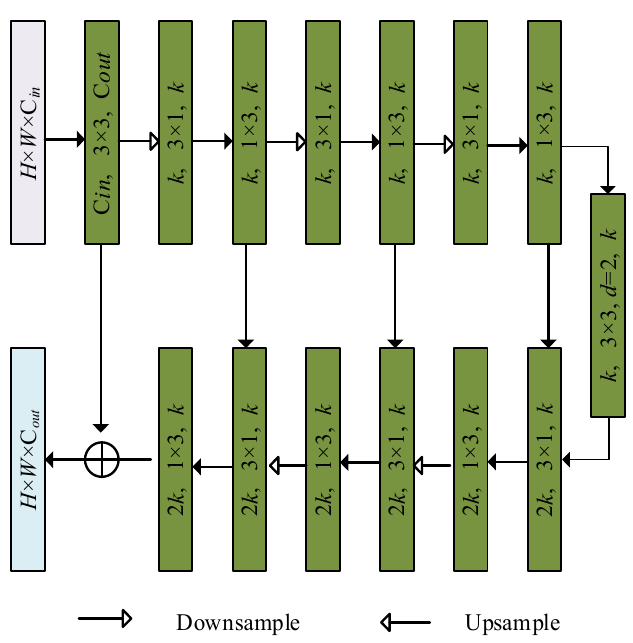
Figure 4. Illustration of the proposed residual U-shaped residual blocks (URB).